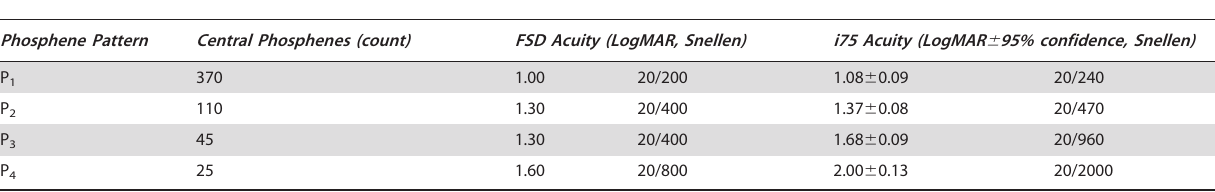
Table 5. Visual acuity values for each phosphene pattern.